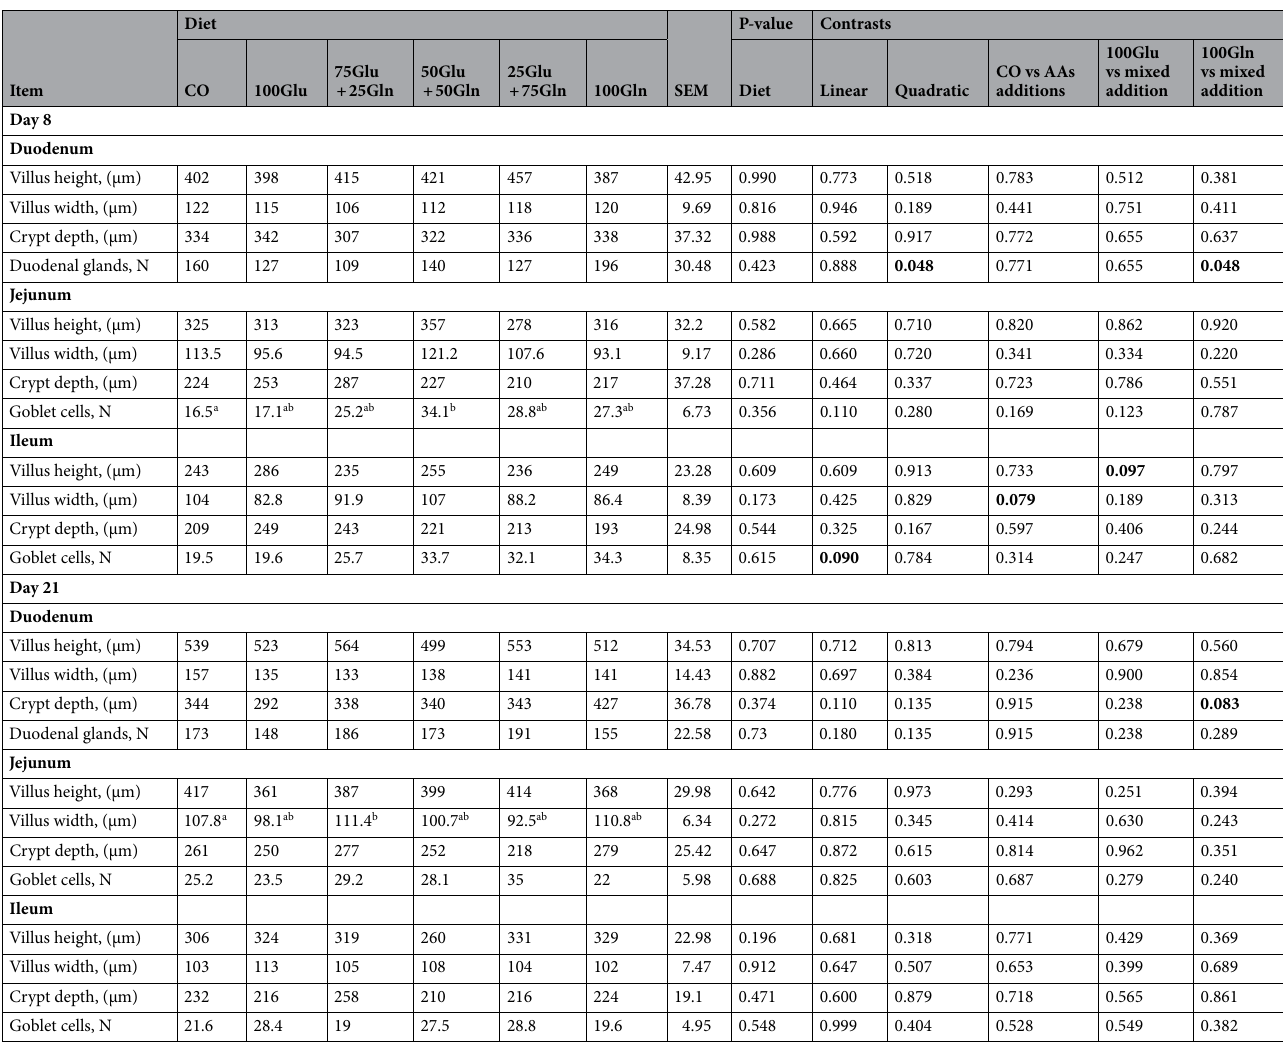
Table 4. Effect of the dietary supplementation (6 kg/T) with glutamate and glutamine in different ratio on the intestinal morphology of piglets at 8- and 21-days post-weaning. Diet 1 CO = standard diet; 100Glu = CO plus 6 kg/Ton Glu; 75Glu + 25Gln = CO plus 4.5 kg/Ton Glu and 1.5 kg/Ton Gln; 50Glu + 50Gln = CO plus 3 kg/Ton Glu plus 3 kg/Ton Gln; 25Glu + 75Gln = CO plus 1.5 kg/Ton Glu and 4.5 kg/Ton Gln; 100Gln = CO plus 6 kg/ Ton Gln. Significant values are in